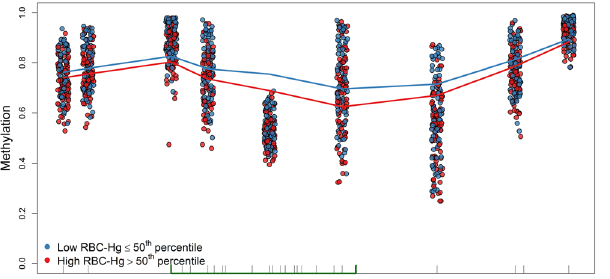
Figure 3. Cord blood CpG methylation distribution and fitted locally weighted scatterplot smoothing (LOESS) lines in the DMR found in PON1 (9 CpGs) with low (blue) and high (red) prenatal mercury exposure among males. Rug plot represents the estimated CpG density in the region while the green area denotes a CpG Island.